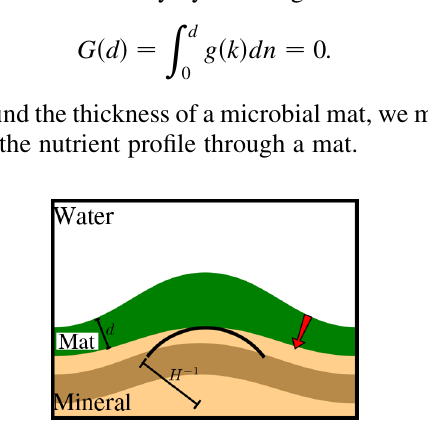
FIG. 7. A toy model of mat growth. Nutrients (arrow) diffuse through a microbial mat and are consumed. Near the nutrient- rich mat surface, the mat grows. At the nutrient-poor mat bottom, the mat decays. As described in Eq. (A15), mat thick- ness is determined by the balance of growth and decay. The equilibrium thickness varies with the curvature of the underlying